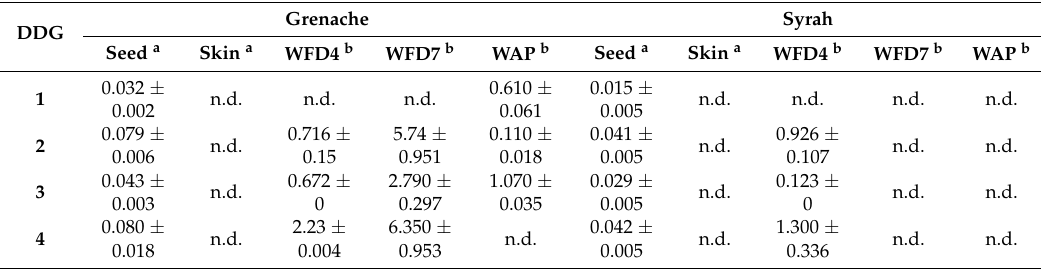
Table 4. Dimeric (epi) catechin diglycoside (DDG) isomers measured in grape seeds and skin, and wine during fermentation at WFD4, WFD7, and